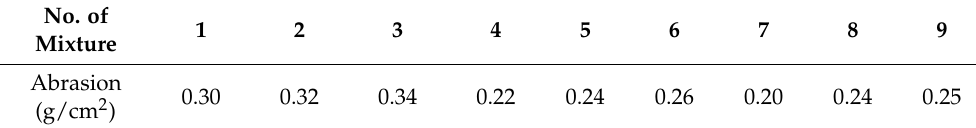
Table 5. Abrasion of the investigated concretes and fiber-reinforced